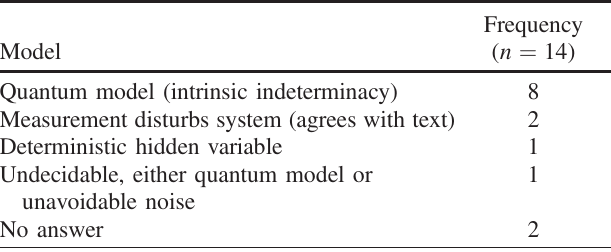
TABLE VI. Principal idea used by students in the answer to T1 (the uncertainty